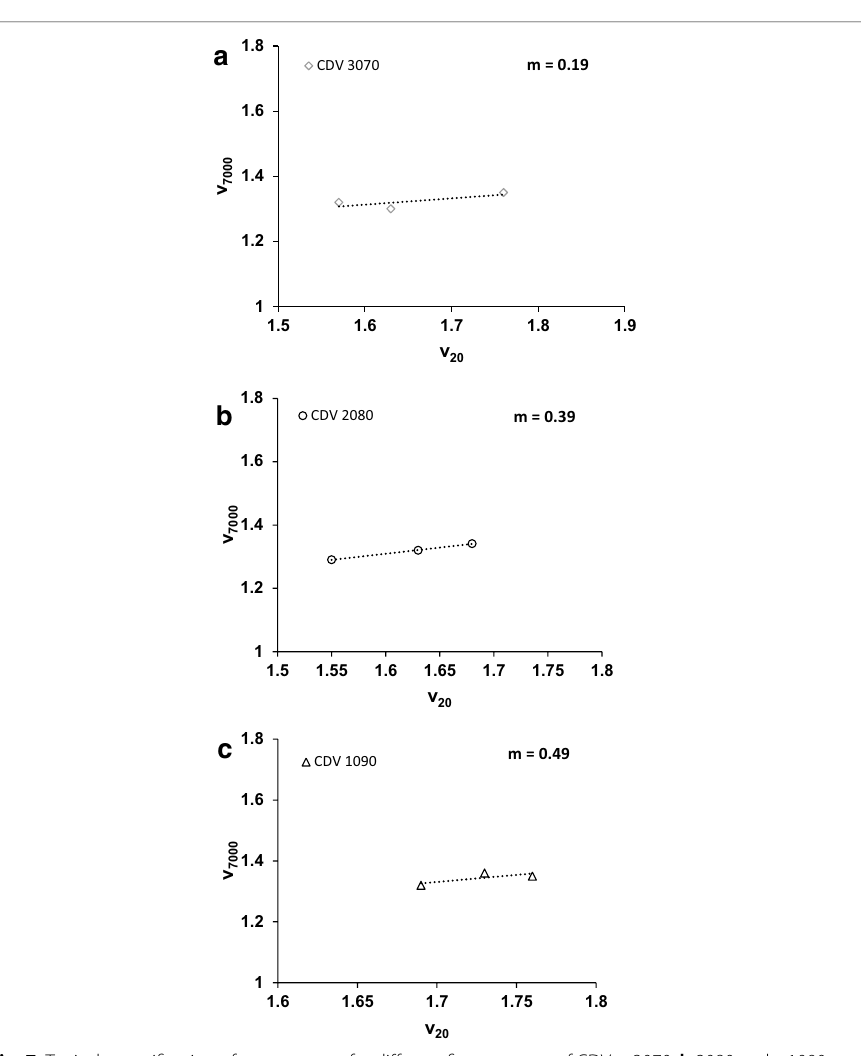
Fig. 7 Typical quantification of convergence for different fines content of CDV. a 3070, b 2080 and c